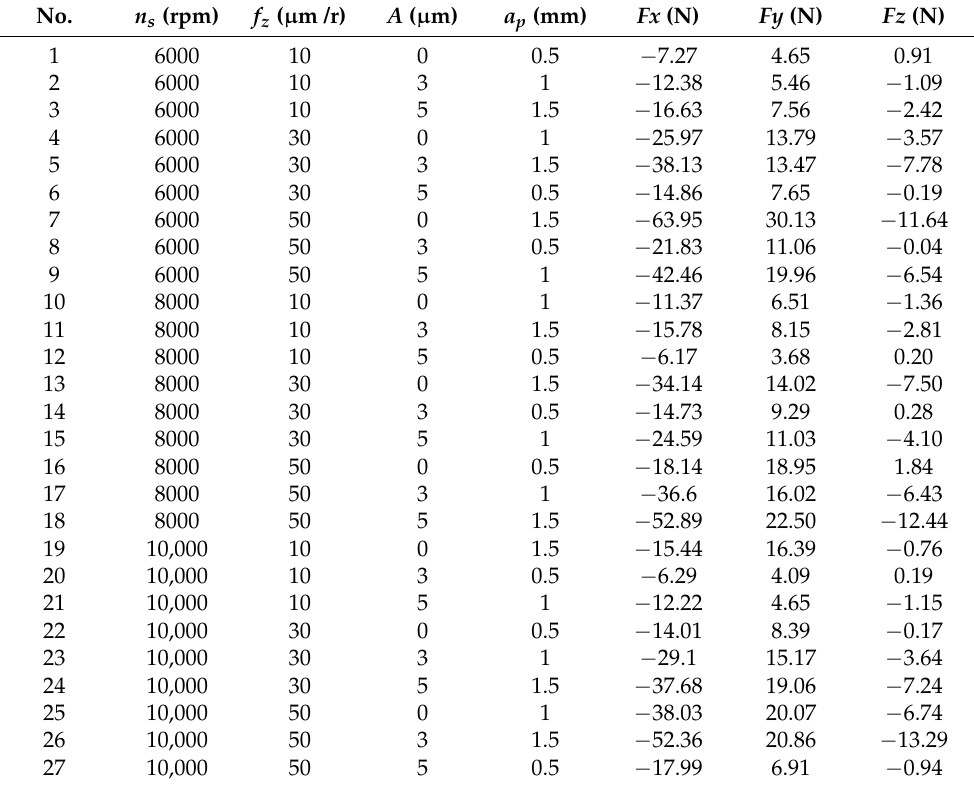
Table 4. The orthogonal test results on the milling force of the 2195 Al-Li